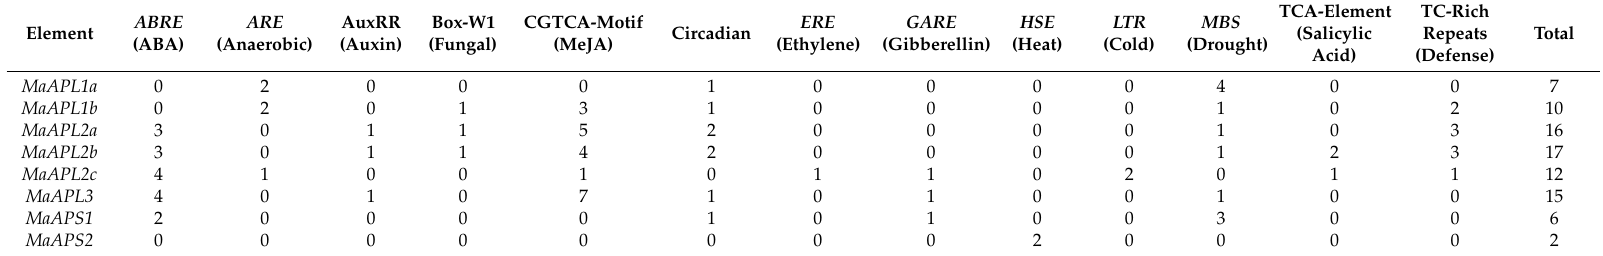
ABRE , ABA responsive element; ARE , anaerobic responsive element; AuxRR, auxin responsive element; Box-W1, fungal elicitor responsive element; CGTCA-motif, MeJA responsive element; Circadian, circadian control; ERE , ethylene responsive element; GARE , gibberellins responsive element; HSE , heat stress responsive element; LTR , low temperature responsive element; MBS , MYB binding site involved in drought induction; TCA-element, salicylic acid responsive element; TC-rich repeats, defense responsive